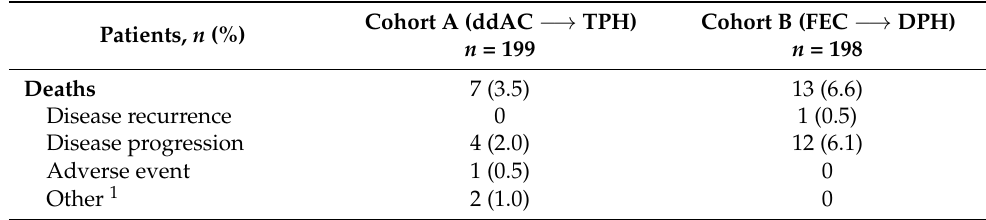
Table 3. Summary of deaths.